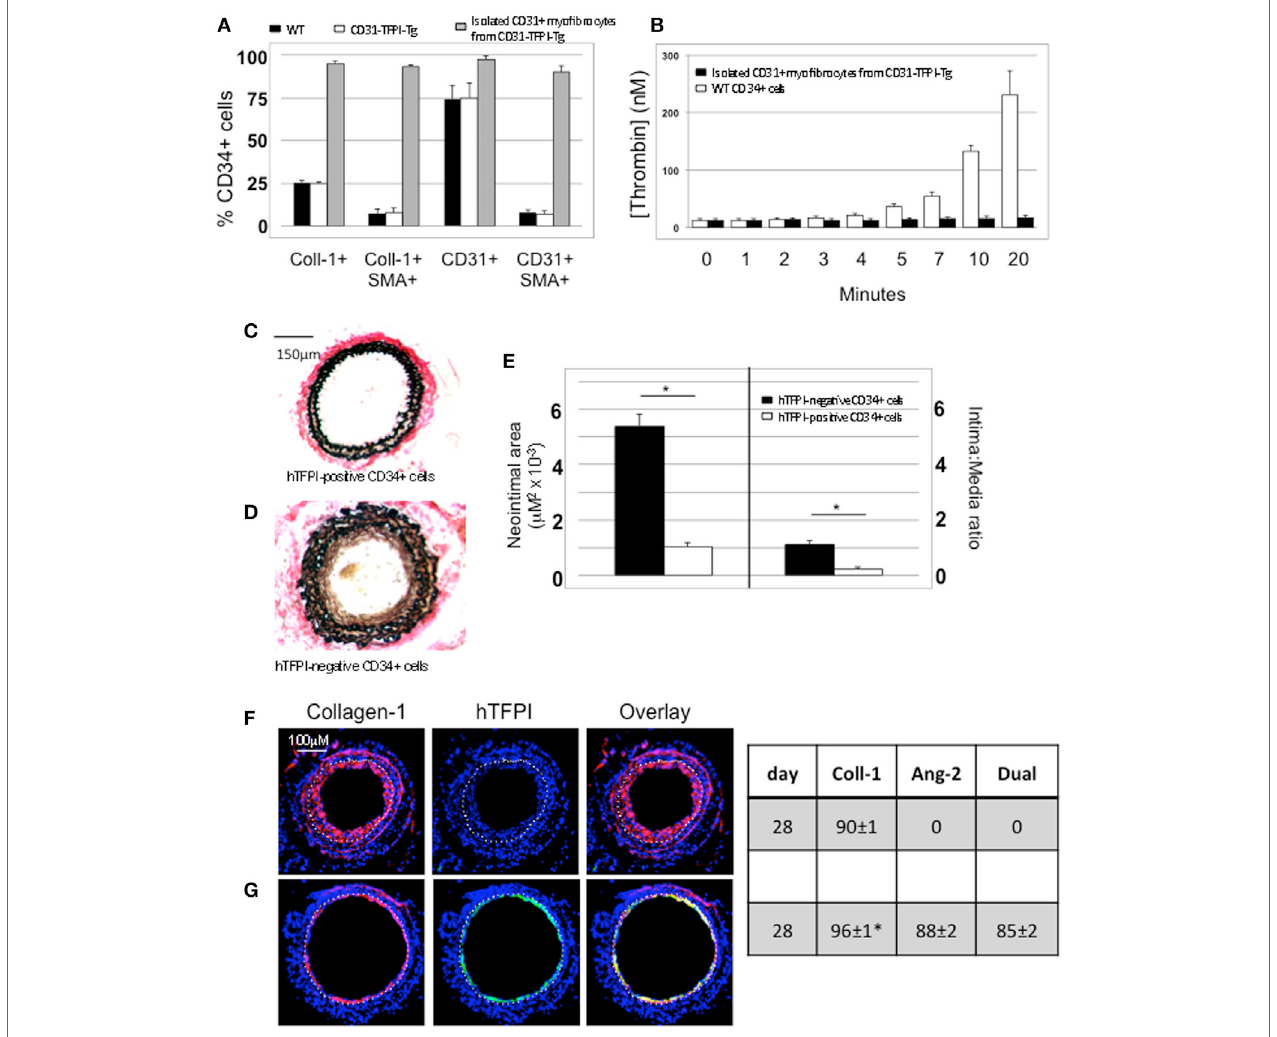
FigUre 4 | Isolation and characterization of CD31 + myofibrocytes from CD31-TFPI-Tg mice. (a) Immunocytofluorescence analysis of CD34 + cells from wild-type (WT) (black bars) or CD31-TFPI-Tg (white bars) mice compared to the purified fraction of CD34 + cells that express human tissue factor pathway inhibitor (hTFPI) on the cell surface (gray bars). Cells were stained with antibodies against anti-smooth muscle actin and either collagen-1 or CD31, and the proportion of cells expressing each was determined. Data are derived from counting at least 100 stained cells from each of five different animals. (B) Thrombin generation assay: CD34 + cells from WT (white bars) or purified CD31 + myofibrocytes from CD31-TFPI-Tg (black bars) were incubated with FXa, FVa, and prothrombin as described in Section “Materials and Methods,” and supernatants harvested at the times indicated for analysis of the amount of thrombin generated. (c–g) Comparison of the functional impact, after adoptive transfer, of the cell-surface hTFPI + and hTFPI-negative fractions of CD34 + cells from CD31-TFPI-Tg mice. (c,D) Cross sectional images of WT carotid artery 28 days post-injury stained with elastin van Gieson’s stain after adoptive transfer of cell-surface hTFPI + fraction (c) or hTFPI-negative fraction (D) on day of injury. (e) Neointimal area (left panel) and intima:media ratio (right panel) of vessels taken from WT animals 28 days post-injury after adoptive transfer of 1 × 10 6 hTFPI-negative (black bars) or hTFPI-positive (white bars) fractions. Data derived from examination of three random sections from five different vessels. * p < 0.01. (F,g) Immunohistology of sections through WT injured mouse carotid arteries harvested 28 days post-injury. All sections stained with DAPI (4,6 diamidino-2-phenylindole) nuclear stain (blue) and (red) anti-collagen-1 and (green) anti-hTFPI. Yellow indicates co-localization. The annotated white line defines the junction between neointima and media. Mice received cell-surface hTFPI-negative fraction (F) or cell-surface hTFPI + fraction (g) of CD34 + cells on day of injury. Table besides panels (F,g) describes summary of staining from all mice ( n = 6), showing the proportion of the neointimal area that is positive for collagen-1, hTFPI, or both on day 28 (% ± SEM). Data derived from three random sections from each of the arteries from each mouse (see Materials and Methods). Subtracting the proportional area occupied by dual positive cells from the total area occupied by hTFPI + cells gives the proportional area occupied by non-adoptively transferred collagen-1-positive cells. *cf hTFPI-negative fraction p = NS. All experiments repeated at least